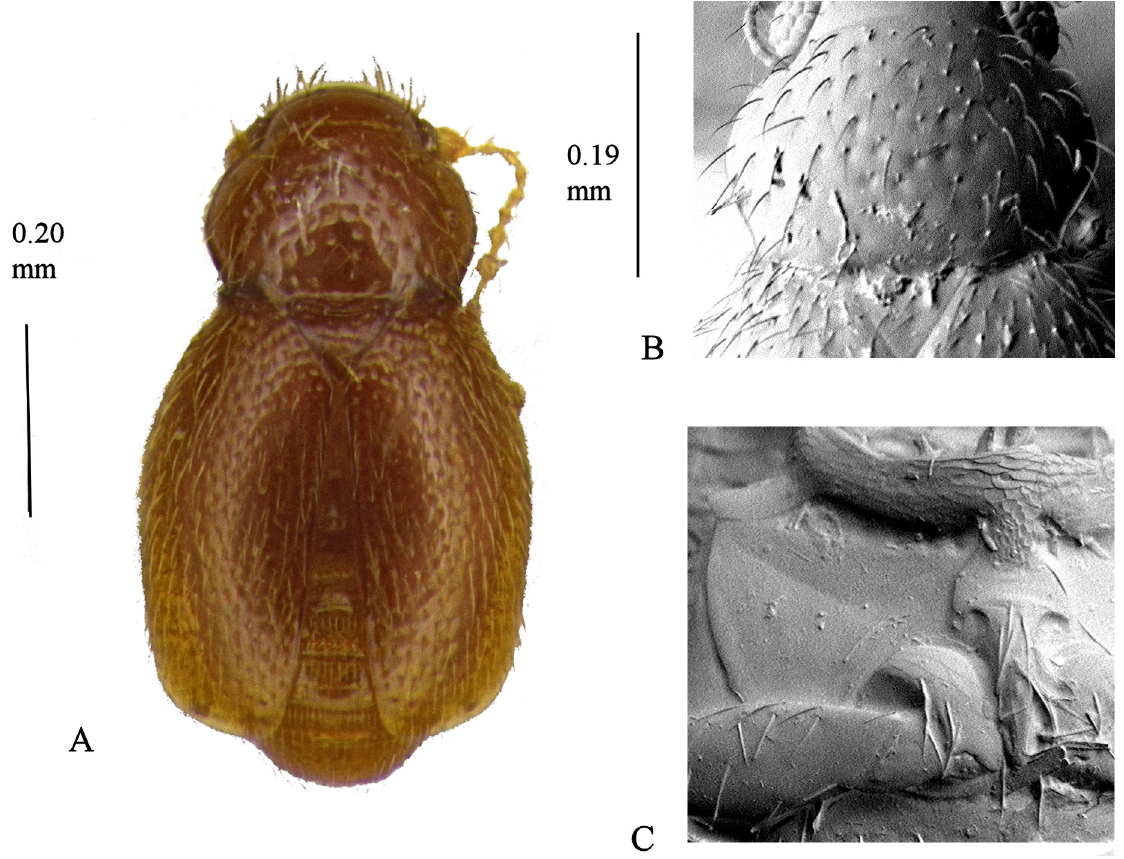
Fig. 69 . Cissidium elongatum Sawada, 2008. A . Habitus. B . Pronotum, × 525 C . Mesoventrite showing median process of collar, mid-keel, keel and lateral margin, ×